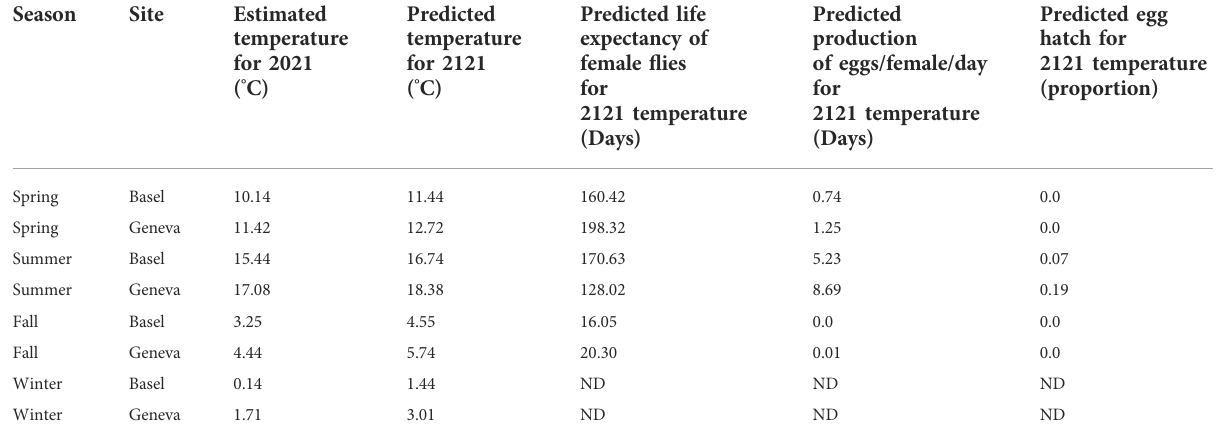
TABLE2The 2021realtemperatureandpredictedtemperaturefor2121in twosites inSwitzerlandandthepredictedlifeexpectancy, eggproduction and egg hatch of A. ludens in such predicted temperatures.